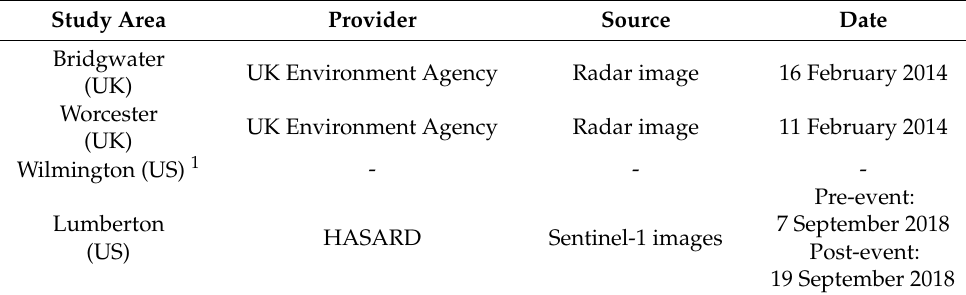
Table 2. Datasets used to inter-compare the resulting maps for each study